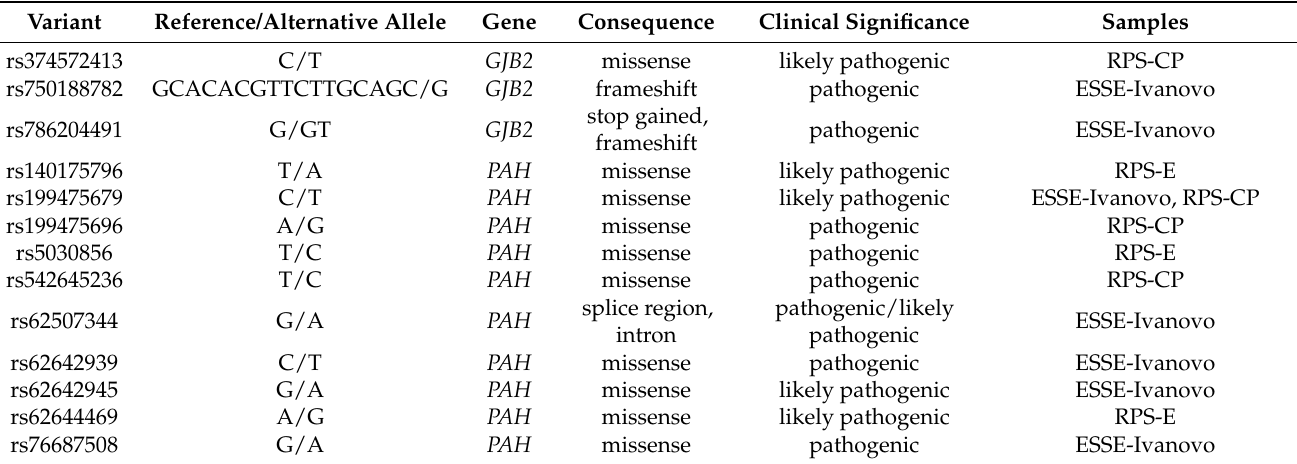
Table 3. List of additional variants found in adjacent sequenced